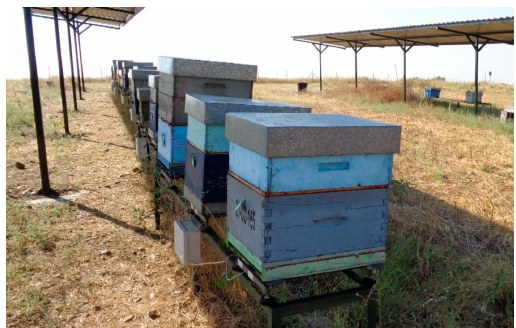
Figure 16. Photograph of the apiary.